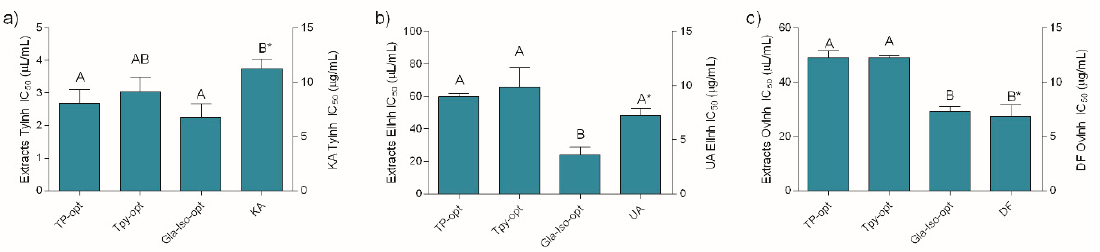
Figure 3. Tyrosinase ( a ) and elastase ( b ) inhibitory, and anti-inflammatory ( c ) activity of the extracts and positive controls KA (kojic acid), UA (ursolic acid) and DF (diclofenac). Di ff erent uppercase letters indicate statistical significance ( p < 0.05). Asterisk (*) indicates that the IC 50 unit is placed on the right y-axis.